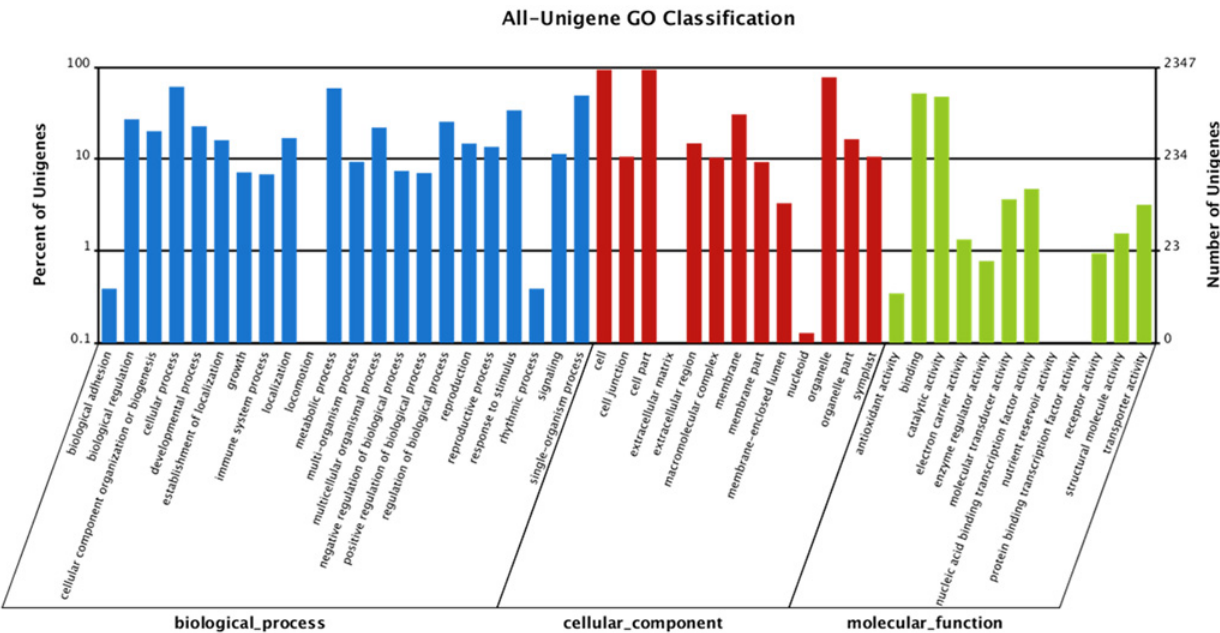
Fig 5. Classification of GO annotations. The x-axis indicates the sub-categories; the left y-axis indicates the percentage of a sub-category of genes in that category and the right y-axis indicates the number of unigenes in a sub-category.